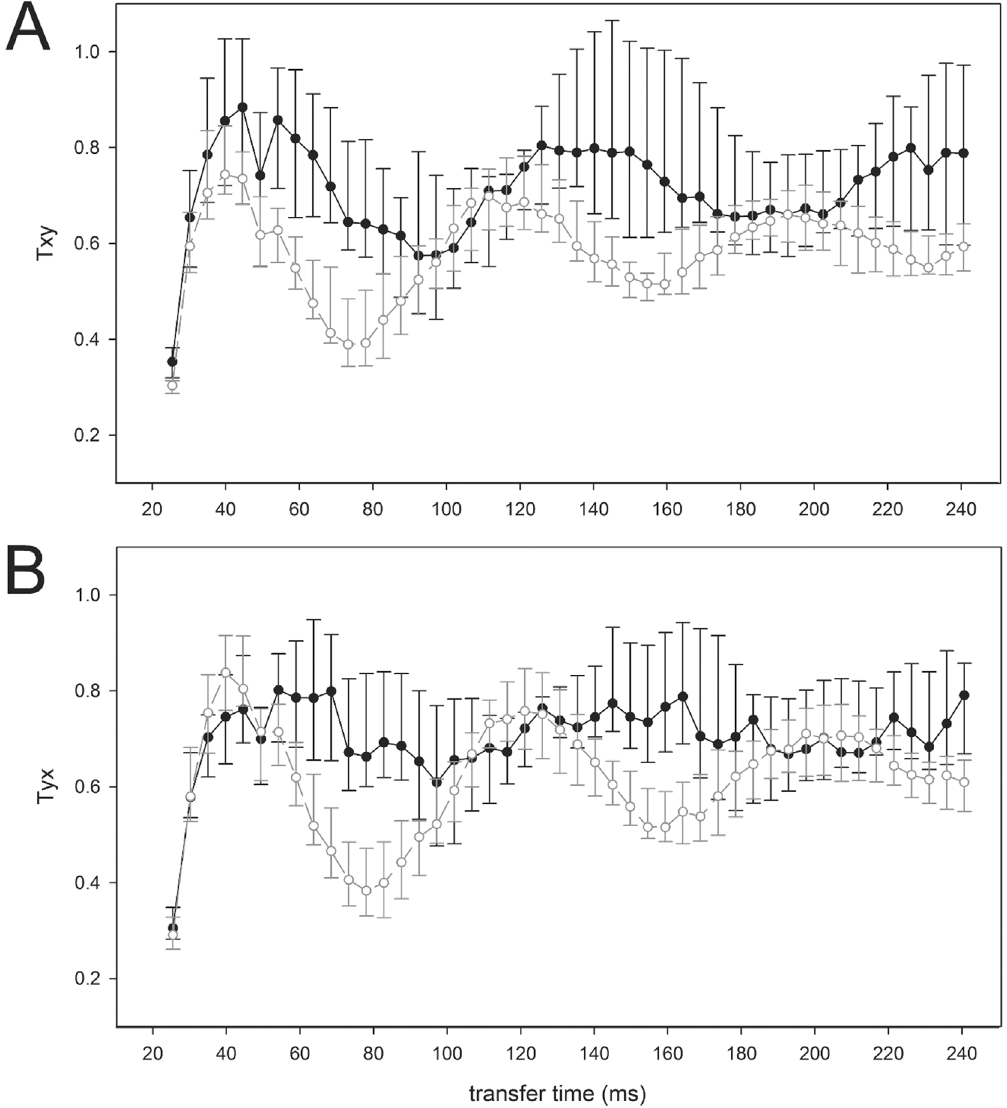
Figure 3. Fluctuating character of directional cortical fronto-parietal connectivity in EEG. Values of directional connectivity (median, 25 th and 75 th percentile) are illustrated with regard to increasing transfer times from 25 ms to 250 ms (A: feedback T conscious; grey: unconscious).